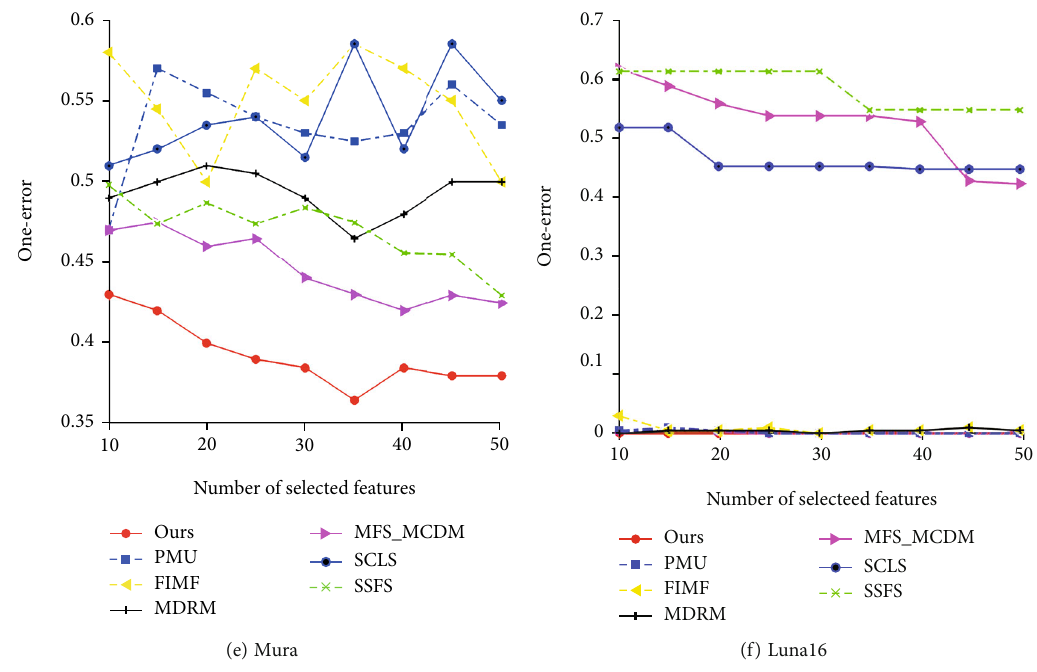
Figure 4: One-error: the quality of each algorithm varies with the selected feature